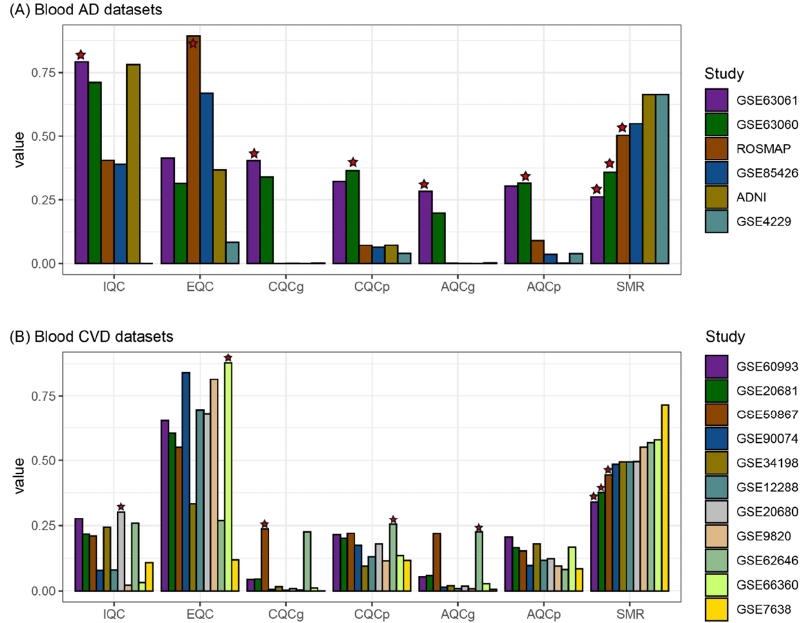
Figure 2. Measurement and comparison of the quality of the blood gene expression datasets using MetaQC. The quality indices were measured by iteratively selecting the four datasets from the six AD blood ( A ) and eleven CVD blood ( B ) gene expression datasets. The heights (y-axis) of each